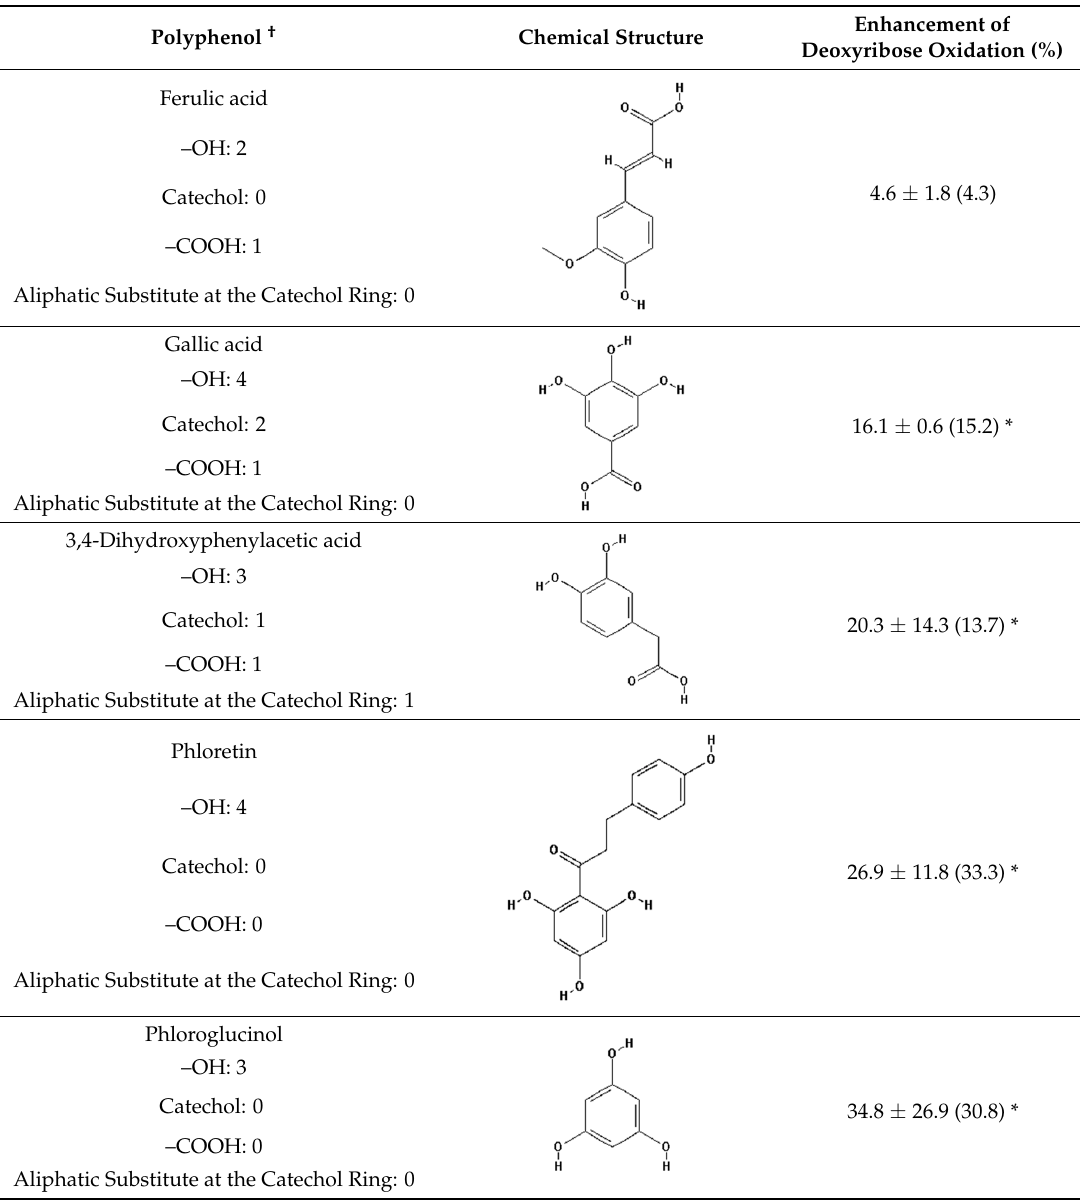
Table 2. Enhancing (pro-oxidant) effect of polyphenols on the oxidative degradation of deoxyribose by the Fenton system (Fe 2+ - ethylenediaminetetraacetic acid (EDTA)-H 2 O 2 ).